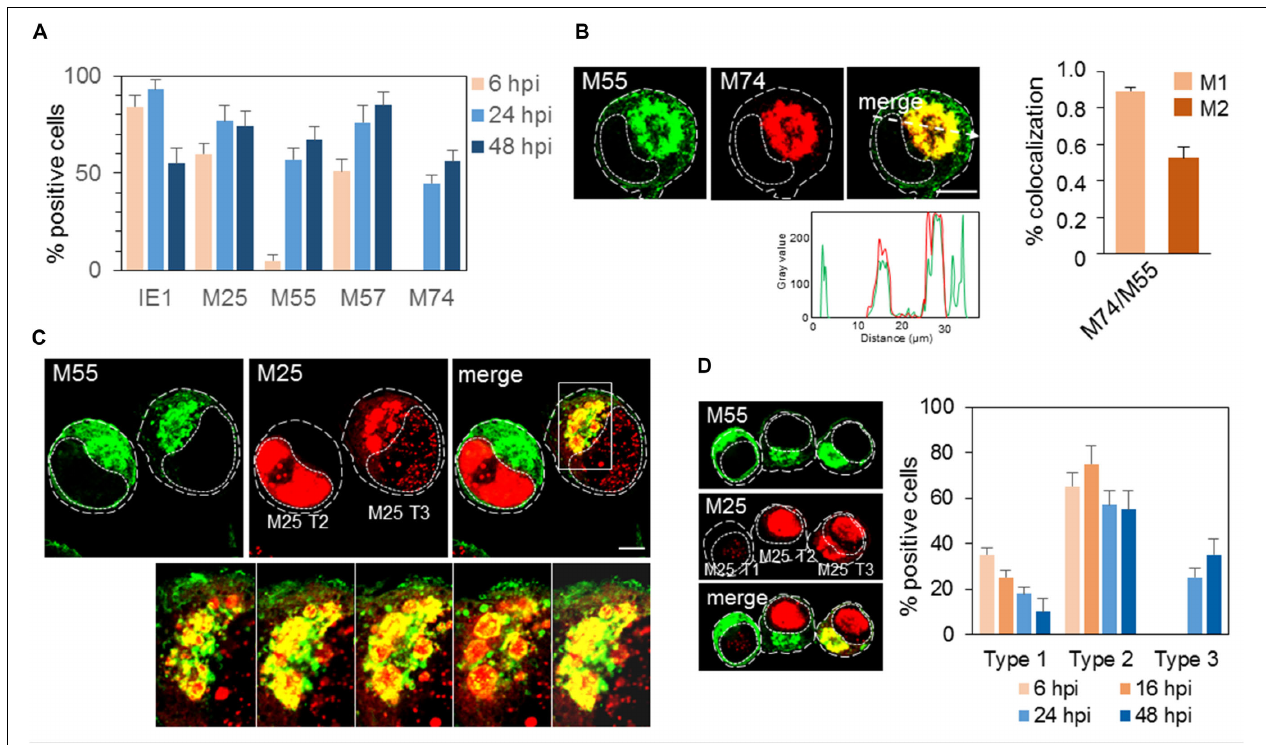
FIGURE 2 | Expression pattern of MCMV-encoded envelope glycoproteins and tegument protein. (A) Percentage of cells that express MCMV-encoded proteins at 6, 24, and 48 hpi determined by immunofluorescence staining with specific mAbs ( Supplementary Table S1 ). The data represent mean ± SEM from four experiments. (B) Colocalization analysis of M55 and M74 . Cells were infected with (cid:49) m138-MCMV (MOI 10) and 48 hpi and stained for expression of M55 and M74. The pixel overlaps coefficients of M74 with M55 (M1), and M55 with M74 (M2) measured across the Costes-algorythm thresholded z-stacks of confocal images are shown in the right. Data represent mean ± SEM per cell ( n = 20). Fluorescence intensity profiles along white dashed lines are shown below images. (C) Colocalization analysis of M55 and M25 . Cells treated as described above were stained with specific mAbs ( Supplementary Table S1 ) and corresponding isotype-specific secondary Abs. Serial images of the boxed area acquired at higher magnification are shown at the bottom. (D) Patterns of M55 and M25 expression . Cells stained for M55 and M25 as described in C were classified according to the pattern of M25 expression (M25 T1, T2, and T3) and the percentage of cells that express one of these patterns determined at 6, 16, 24, and 48 hpi. T1, cells that express M55 but not M25; T2, cells that express M55 and M25 in the nucleus; and T3, cells that express M55 and either M25 in both nucleus and cytoplasm or only in the cytoplasm. The data represent mean ± SEM from three experiments. Cell borders are indicated by fine dashed lines and nuclei by fine dotted lines. Bars, 10 µ m. 2-column fitting image.